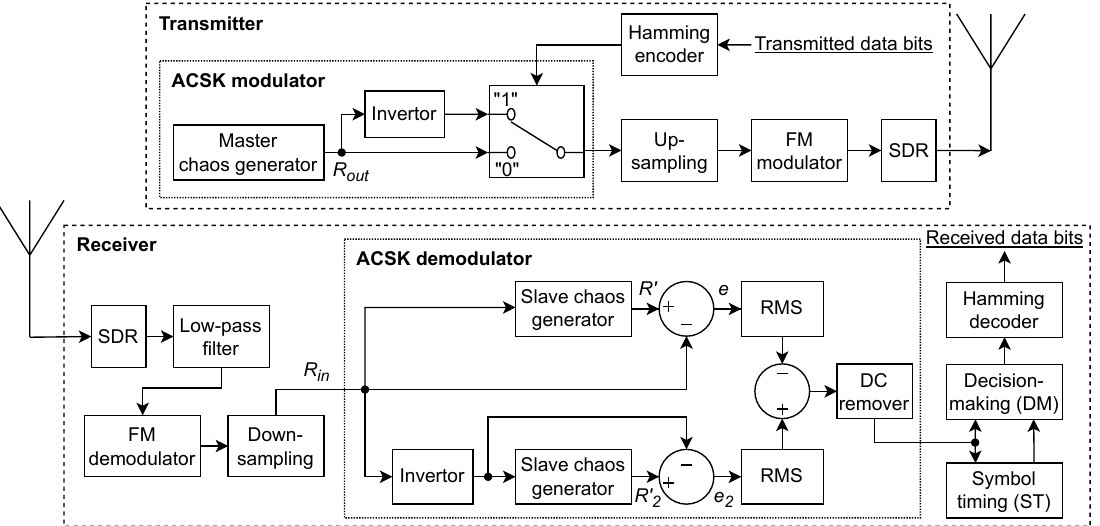
Figure 3. Block diagram of SDR-based FM-ACSK transceiver.